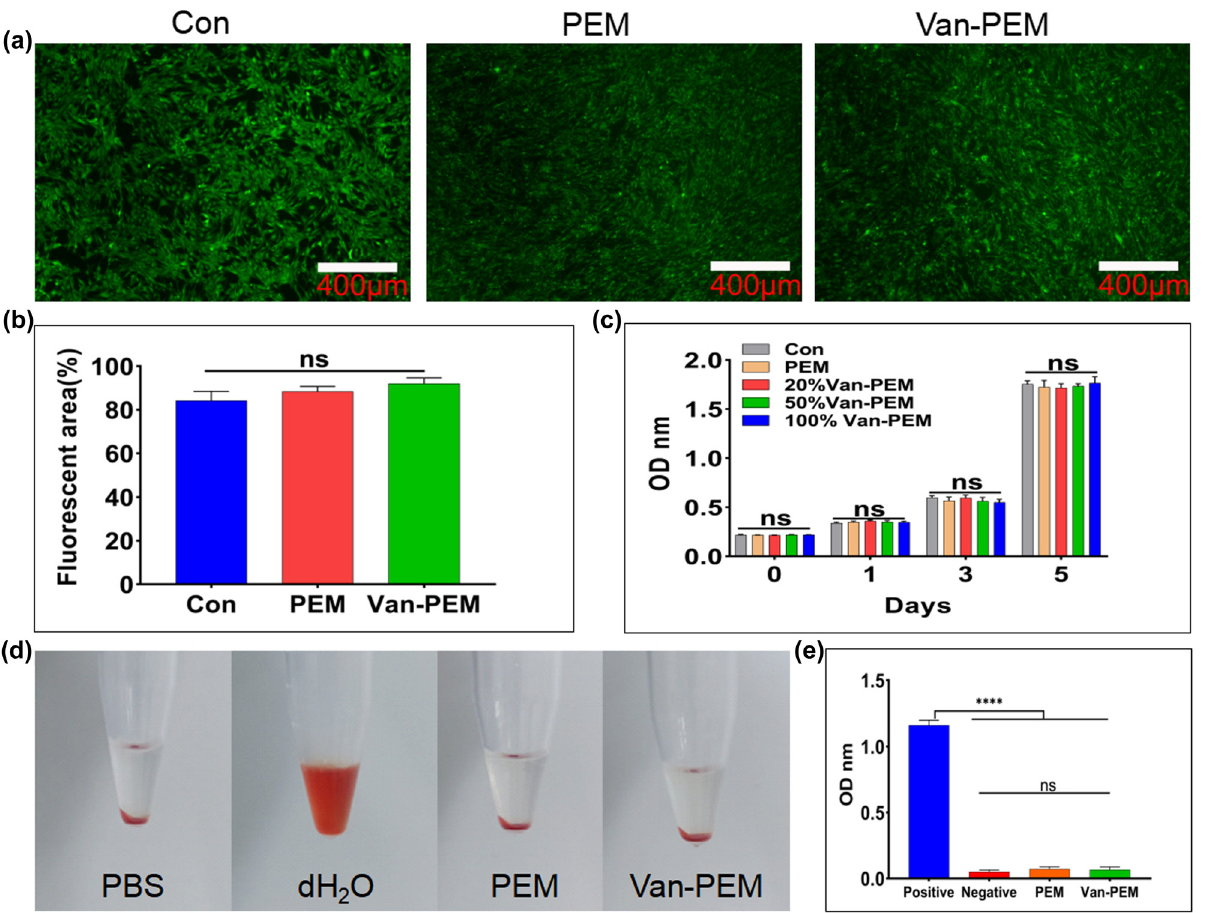
Figure 5: ( a ) Calcein staining after co - culture of the PEM and Van - PEM hydrogels with BMSCs. ( b ) Fluorescence staining areas in ( a ) calculated using ImageJ software. ( c ) BMSCs cultured with PEM hydrogel and Van - PEM hydrogel extracts of di ff erent concentrations. ( d ) Hemolysis reactions of PEM and Van - PEM hydrogels. PEM and Van - PEM hydrogels do not cause hemolysis. ( e ) Absorbance of hemoglobin in the supernatant of ( d )